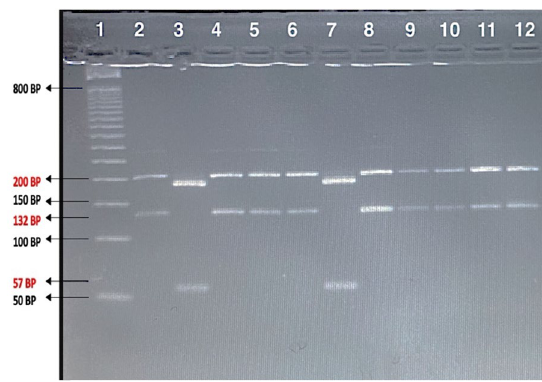
Figure 3. MetaPhor (4%) Agarose gel for Leishmania speciation isolated from clinical specimen of CL patients by analysis of restriction pattern of ITS1 PCR/nPCR products using restriction enzyme ( HaeIII ). Lane 1: 50 bp DNA ladder; lane 2: L. major MHOM/TM/82/ Lev positive control (203 and 132 bp); lane 3: L. tropica MHOM/ SU/80/K28 positive control (200 and 57 bp); lanes 4–6 & 8–12: L. major samples; lane 7: L. tropica sample.